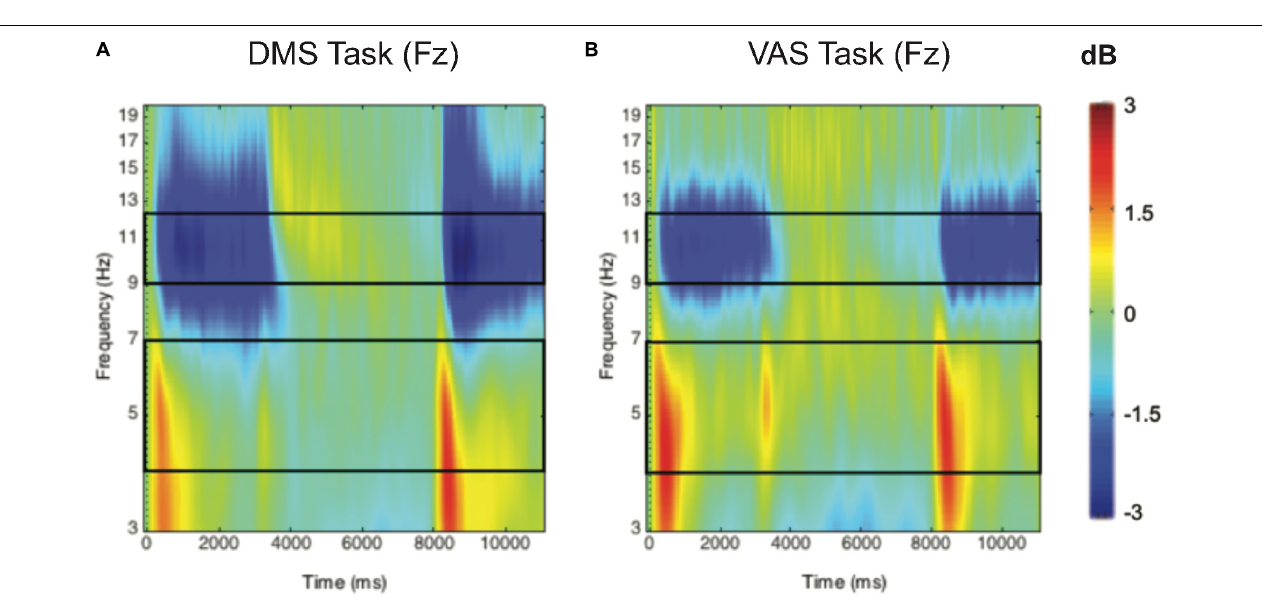
FIGURE 2 | Group-averaged time-frequency 2D spectra (in dB) during a DMS task (A) and a VAS task (B) for the Fz electrode. Time (in ms) is indicated on the x -axis, with 0 ms defined as the onset of the sample stimuli and 8000 ms for the onset of the probe stimuli. Frequency (in Hz) is shown on the y -axis and is logarithmically scaled from 3 to 20 Hz. The event-related desynchronization (ERD) corresponds to negative values and is shown in blue, while the event-related synchronization (ERS) appears in red.